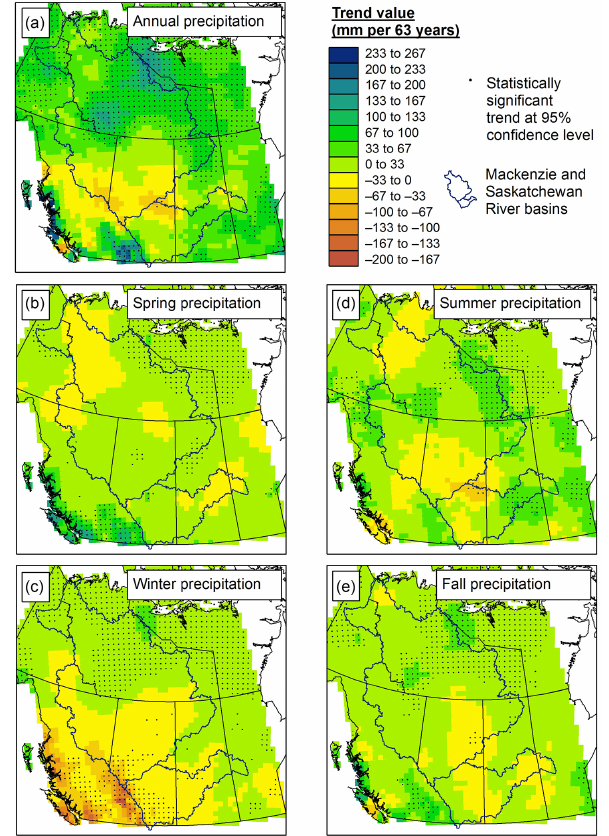
Figure 5. Spatial patterns of trends (millimetres per 63 years) in an- nual and seasonal totals of precipitation over the period 1950–2012 across western Canada, based on analysis of CANGRD precipita- tion